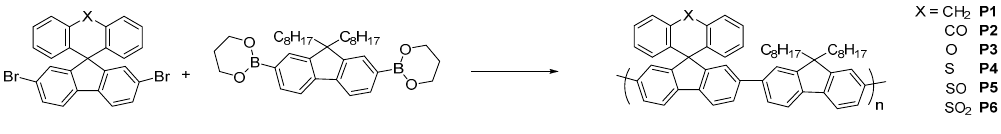
Figure 2. Molecular structure and synthesis of polymers P1 – P6 .